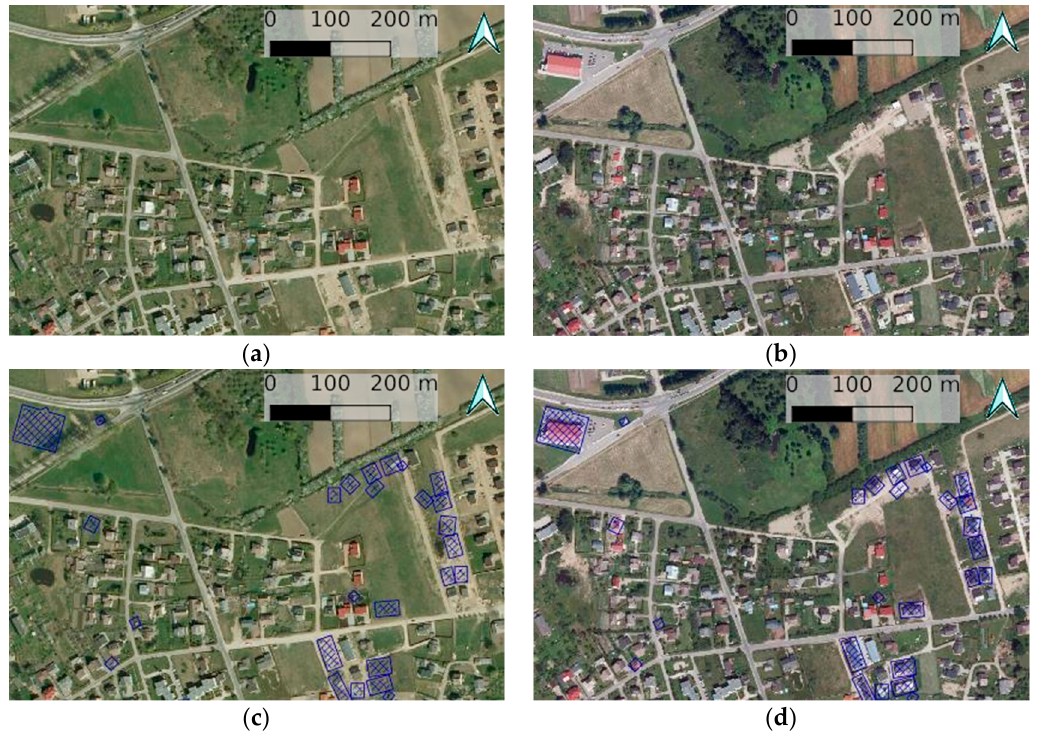
Figure 13. The example of change identification: ( a , b ) Original ORTO10LT images of periods 2009–2010 and 2012–2013, respectively; ( c , d ) images with a hatch layer which represents mismatch of the building class in segmentation results.